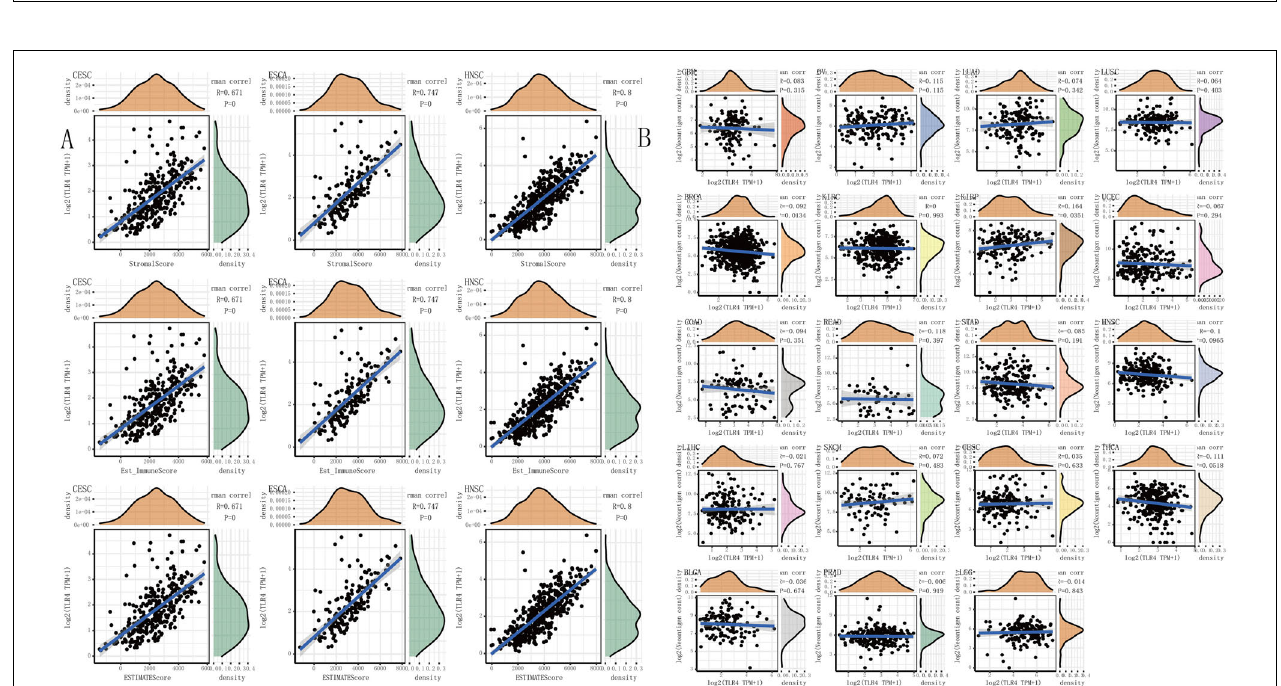
FIGURE 4 | The relationship between the TLR4 gene expression and immune score, neoantigens. (A) The expression of TLR4 gene in the ESTIMATE immune score was concerned with CESC ( p = 0), ESCA ( p = 0), HNSC ( p = 0) are prominently correlated. (B) KIRC, SKCM, STAD, TGCT, and UCEC were not notably related to neoantigens. A p -value < 0.05 was considered statistically significant. The symbols “*,” “**,” and “***” refer to p -values < 0.05, < 0.01, and < 0.001, respectively.